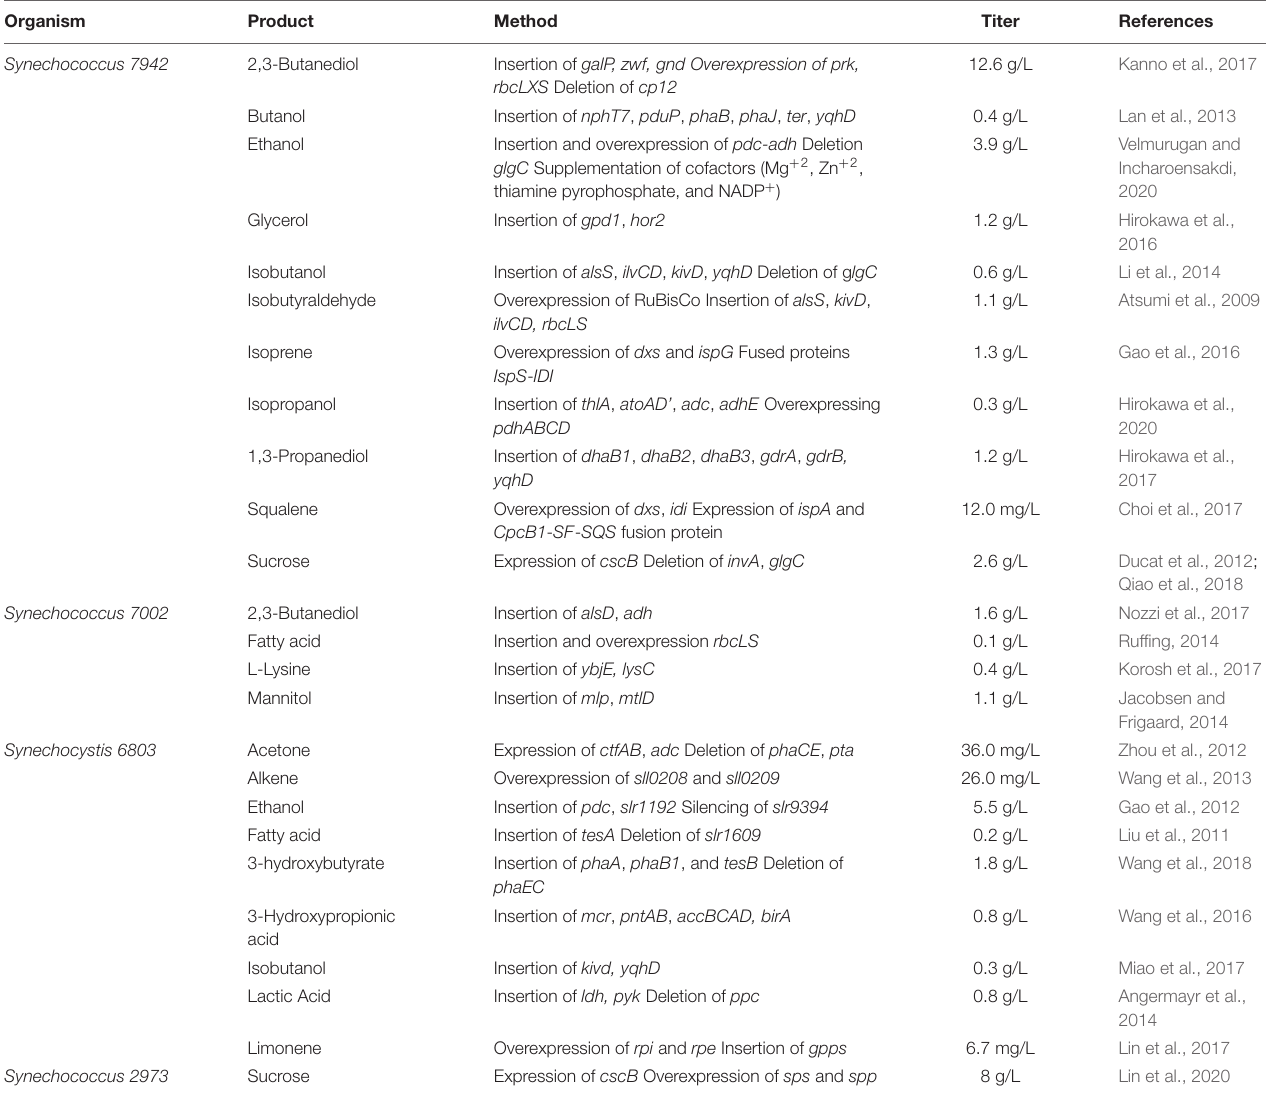
TABLE 1 | Cyanobacteria as cell factories: the production of heterologous products via genetic modification and the production titers thereof.